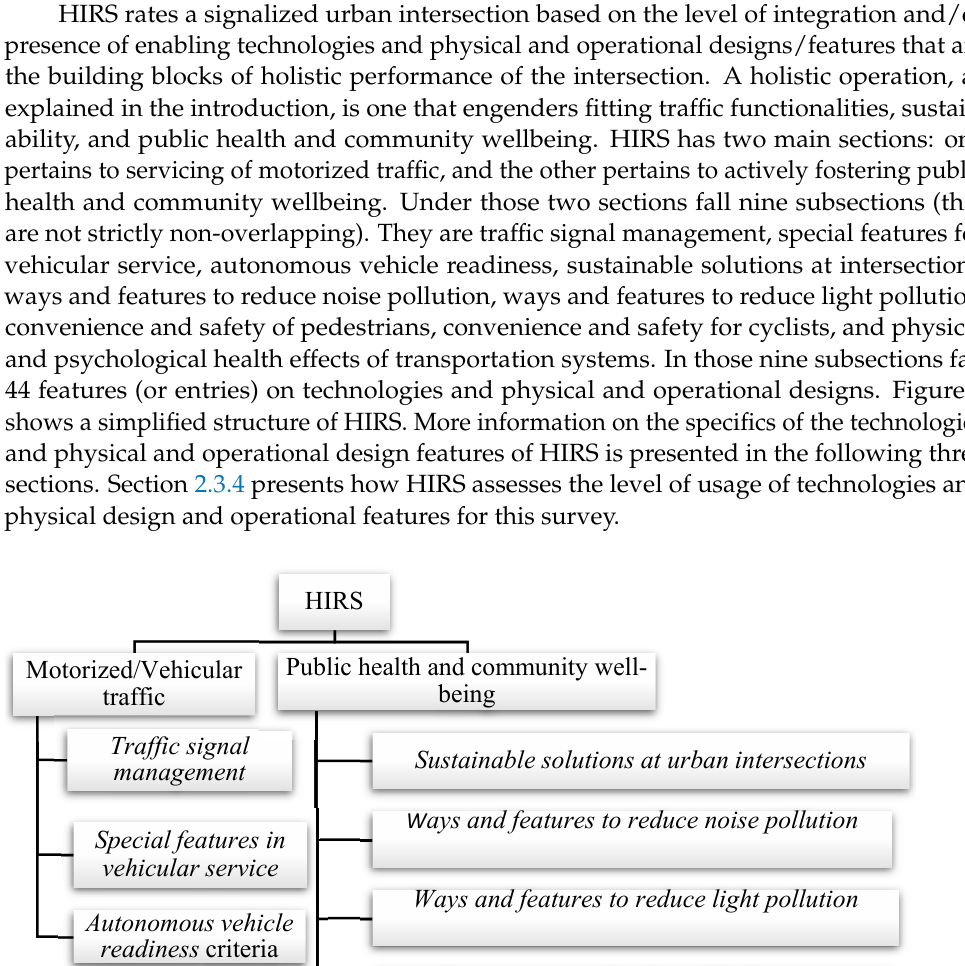
Figure 2. HIRS structure.